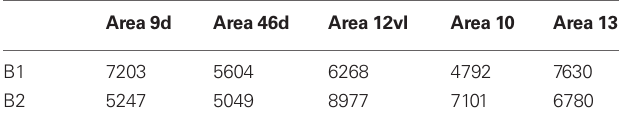
Table 11 | estimates of the total number of spines in the basal dendritic tree of the “average” layer iii pyramidal cell in prefrontal areas of the Chacma baboon.